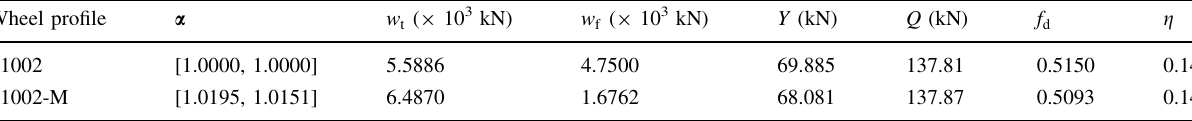
Table 4 Comparison of results calculated by KSM Wheel